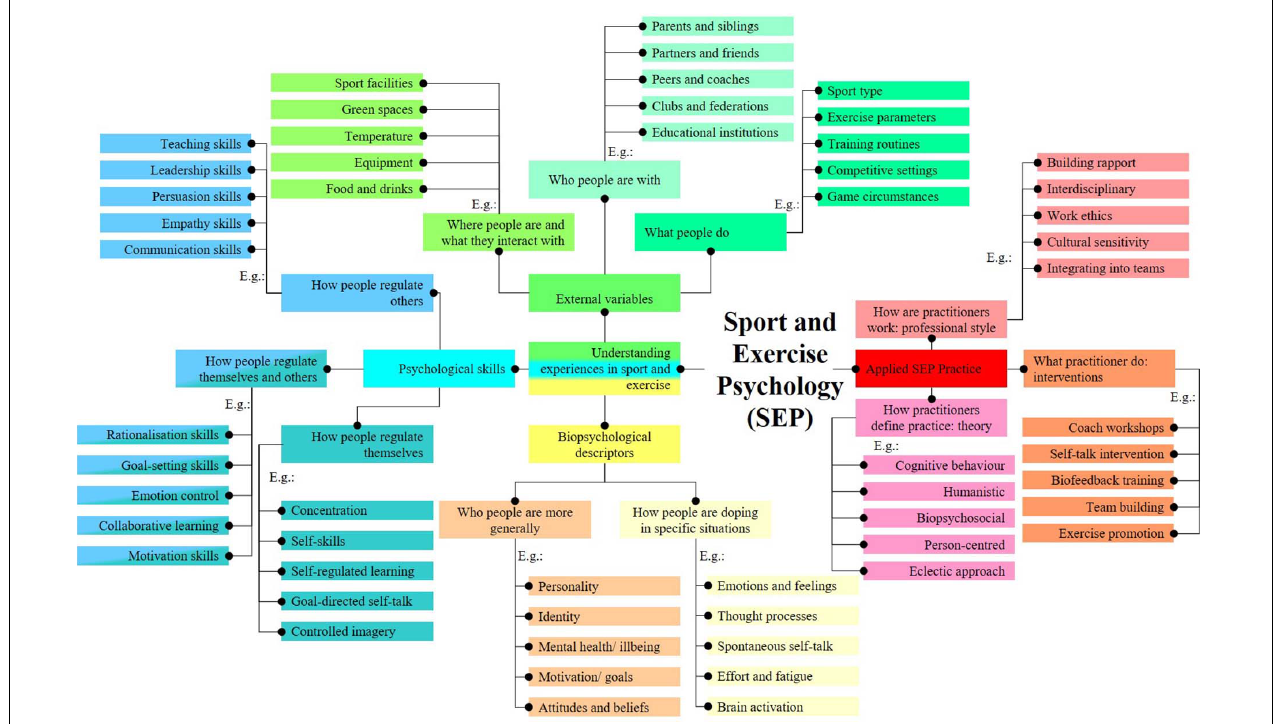
FIGURE 1 | A conceptual map of sport and exercise psychology research